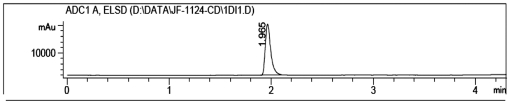
HPLC chromatogram of salidroside.Note that the preparation of salidroside is 100% pure.